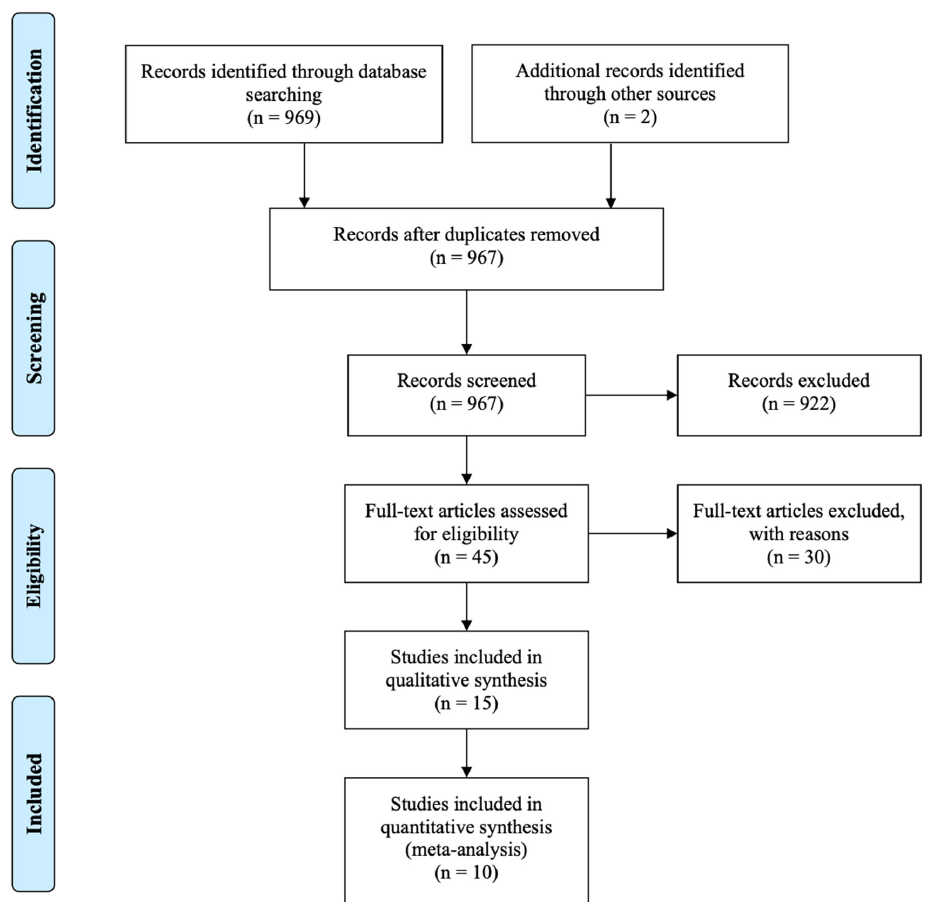
Figure 1. Preferred Reporting Items for Systematic Reviews and Meta-Analyses (PRISMA) flow diagram of selection